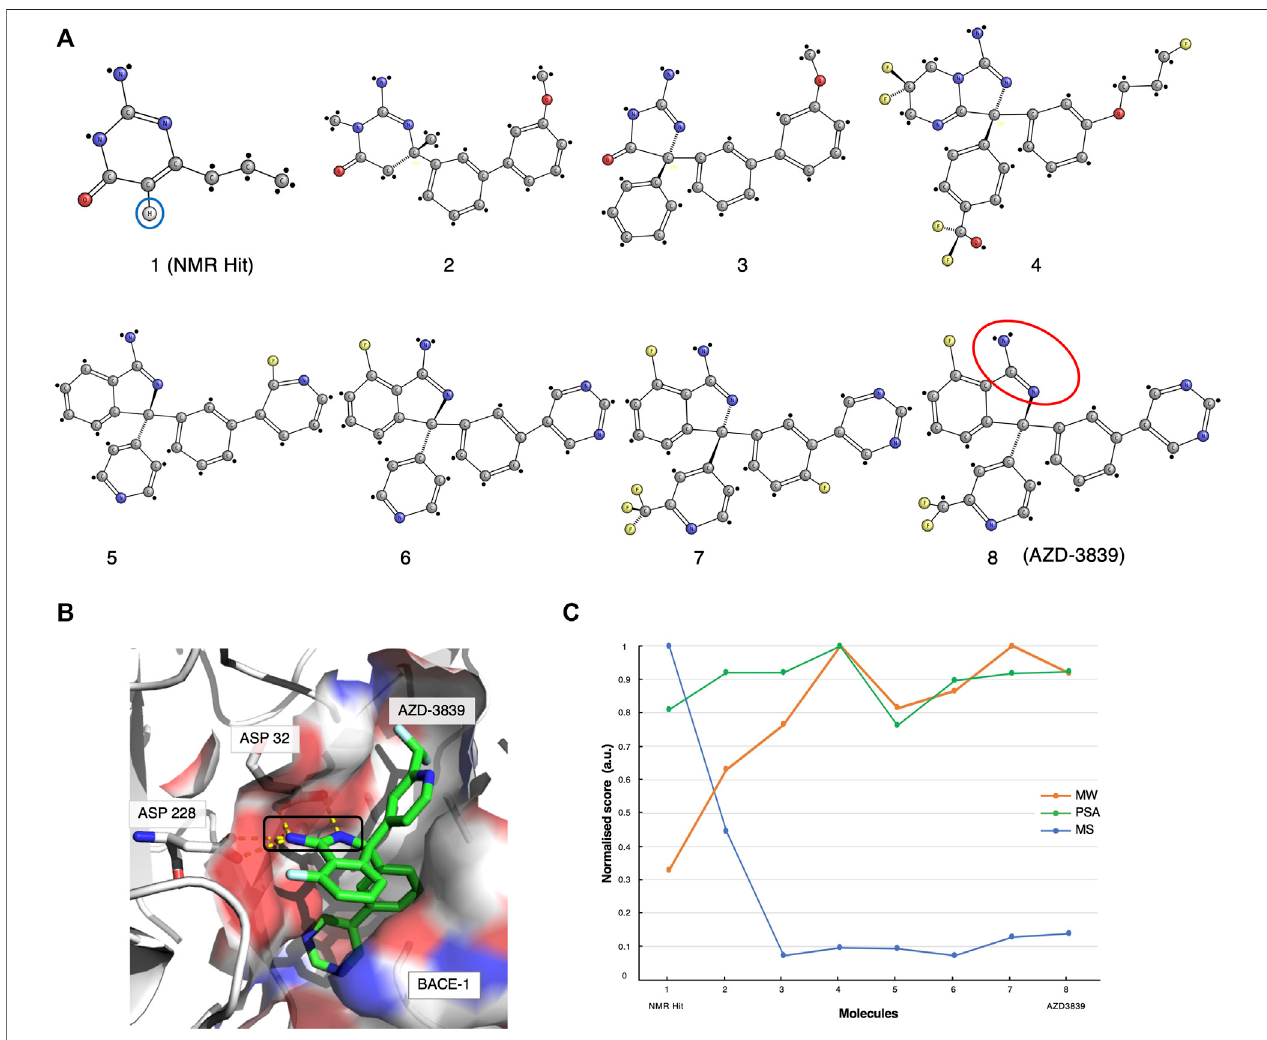
FIGURE 2 | The AZD-3839 case-study. (A) The optimisation pathway: from NMR hits to AZD-3839. Compound- 1 represents the hit initially identi fi ed from the Water-LOGSY NMR study. The blue circle highlights the crucial isocytosine aromatic proton. Compounds were optimised through a series of crystallography-based methods to yield the fi nal compound- 8 (AZD-3839) (Geschwindner et al., 2007; Jeppsson et al., 2012), yet preserving the original amidine motif (red circle) already present in compound- 1 . (B) Molecular structure representation of BACE-1 (PDB code: 4B05) and the main interaction between the catalytic groove (Asp32 and Asp228) and the amidine group of AZD-3839, fi rst observed in the NMR-discovered hit (black rectangle). (C) Molecular similarity, as expressed by the Tanimoto coef fi cient(MS,Blue), normalisedmolecularweight(MW,orange) and polarsurfacearea(PSA, green)scoresfortheeightcompounds onthedevelopmentpathofAZD-